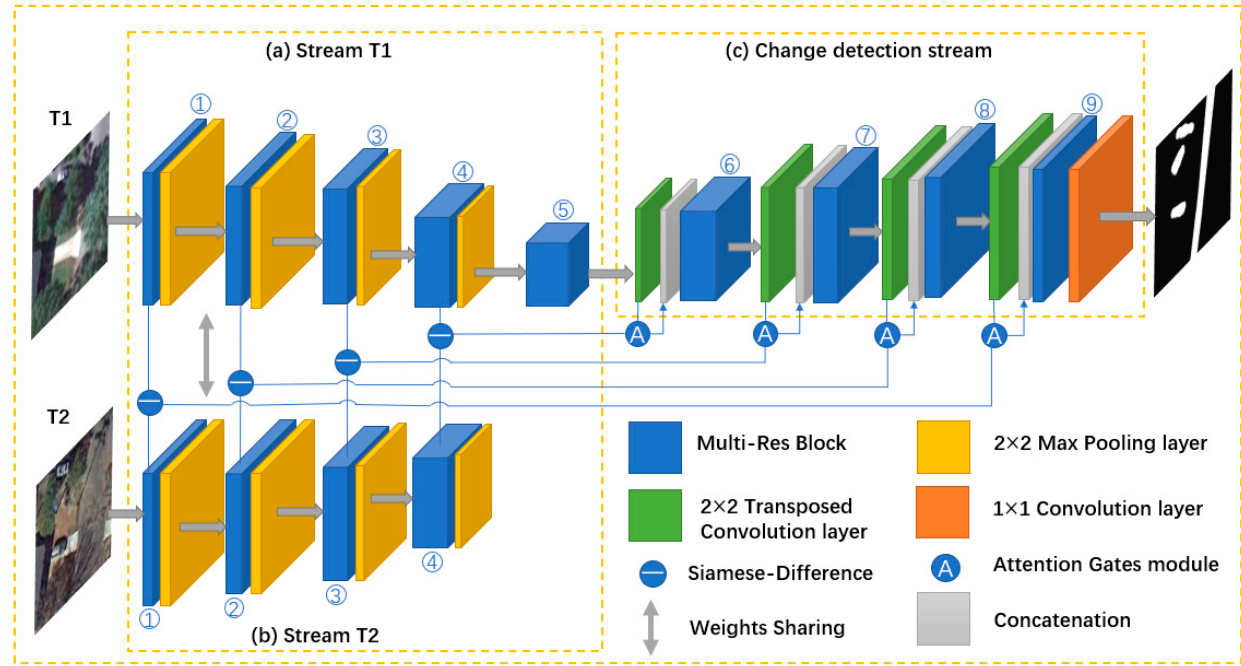
Figure 1. Architecture of the proposed MRA-SNet network. ( a ) Stream T1, ( b ) Stream T2, ( c ) Change detection stream.